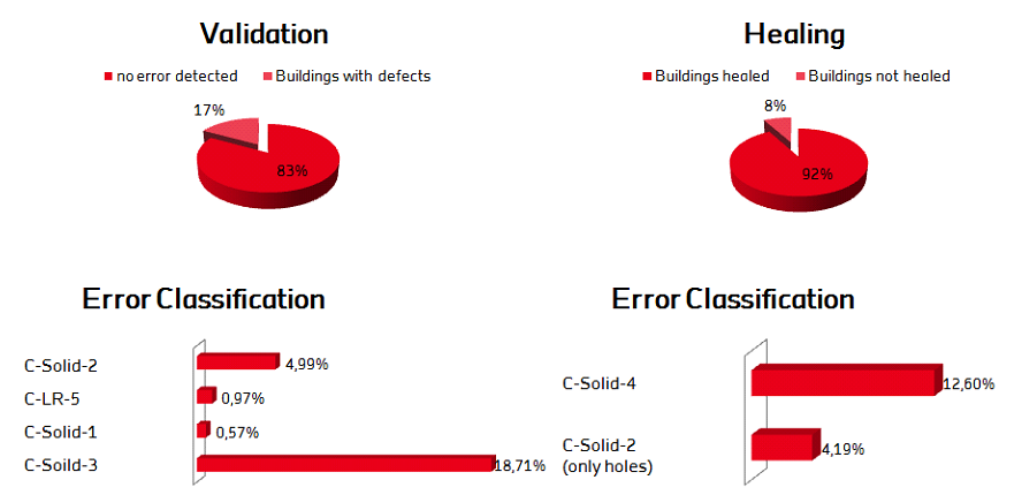
Figure 6: Validation and healing